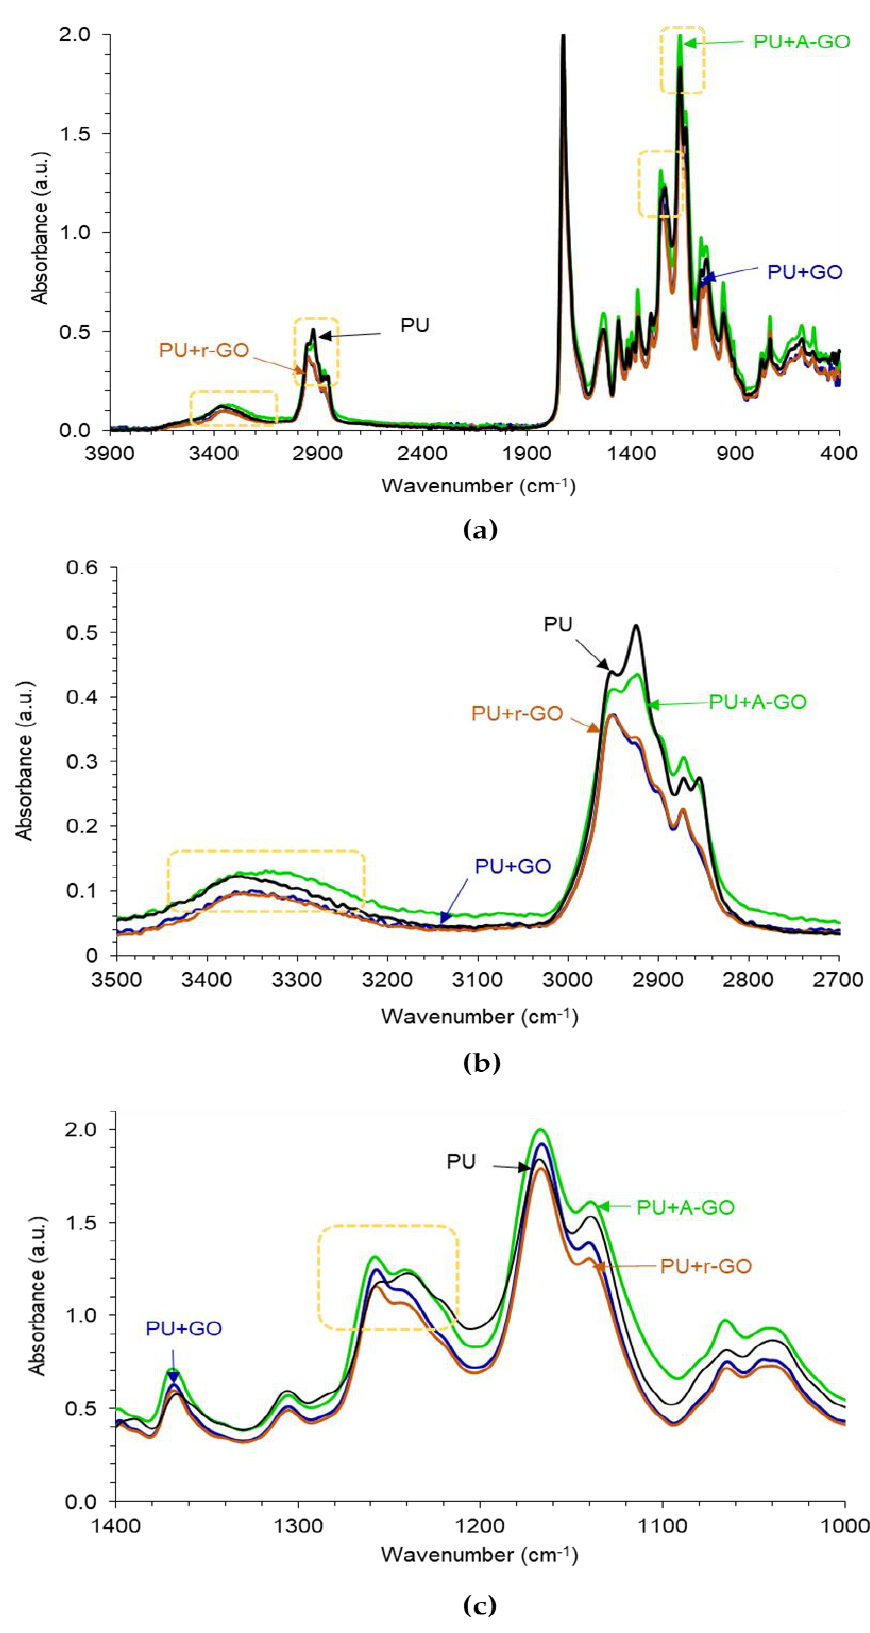
Figure 9. ( a ) ATR-IR spectra of the PUs without and with GO derivatives; ( b ) 3500–2700 cm − 1 region, and ( c ). 1400–1000 cm − 1 region of the ATR-IR spectra.